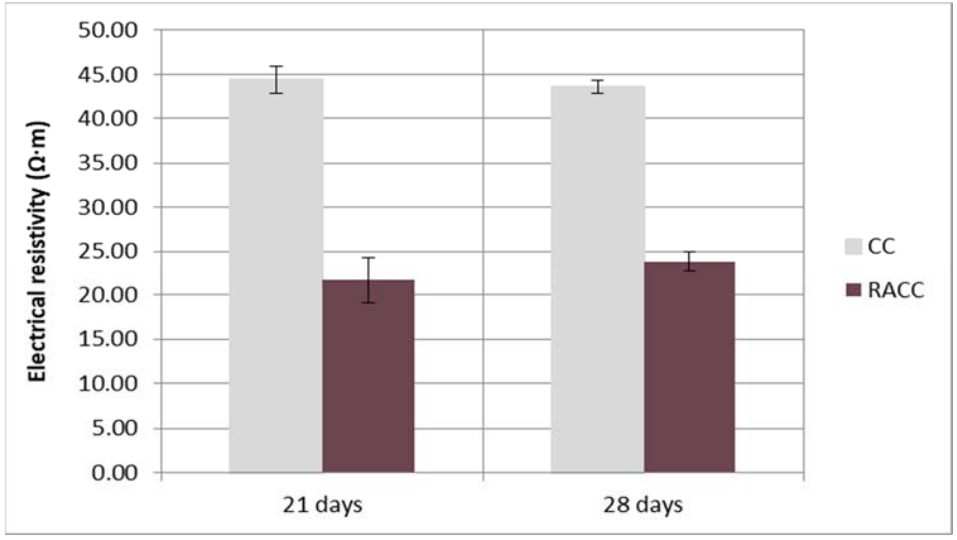
Figure 7. Electrical resistivity in 21 d and 28 d CC and RACC samples .